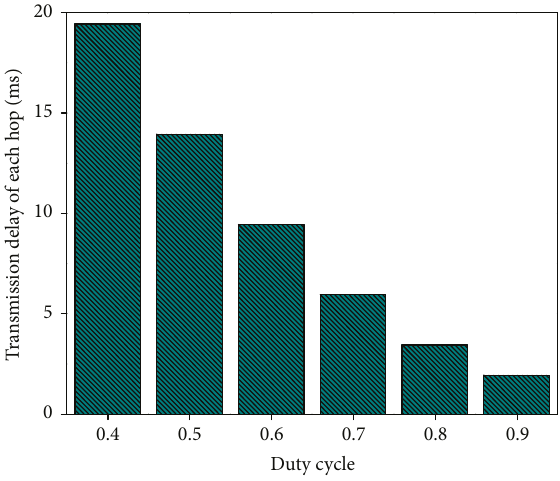
Figure 4: The transmission delay of each hop of network with di ff erent duty